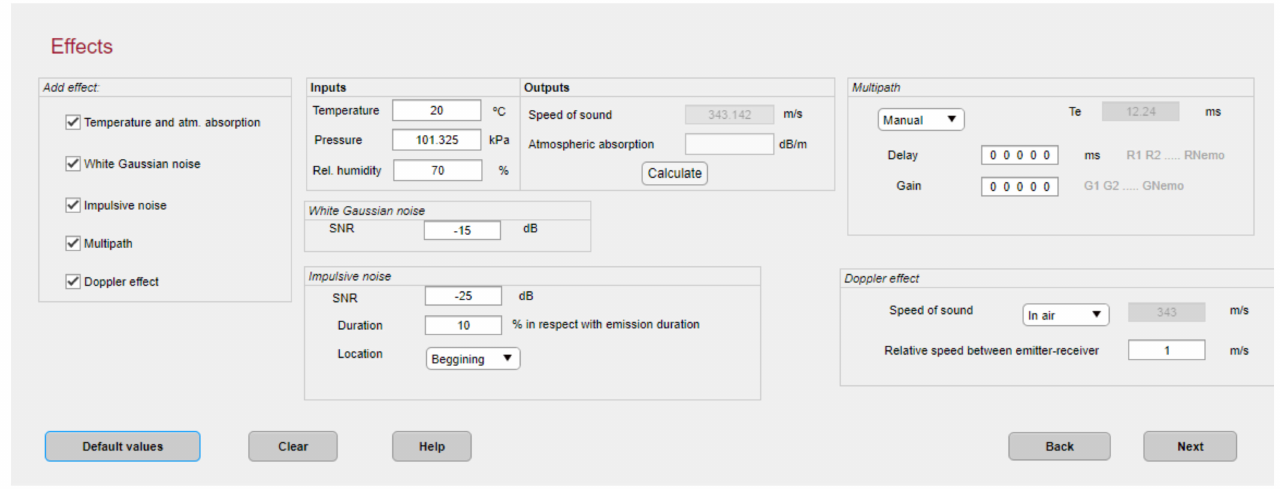
Figure 9. Configuration of different channel phenomena in the CODEUS simulator